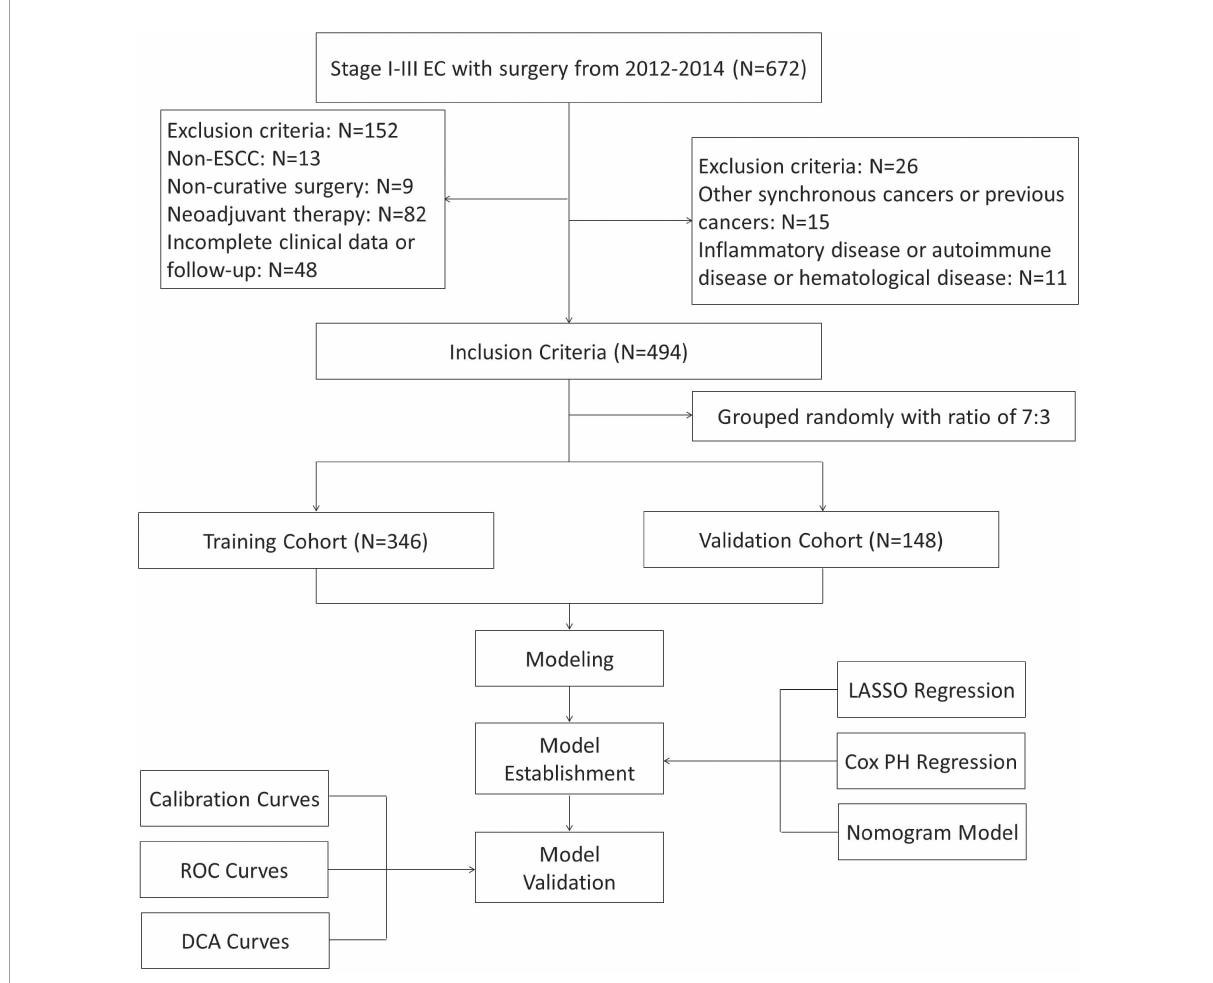
FIGURE1 The flow diagram of selection esophageal squamous cell carcinoma (ESCC) patients with radical resection. Based on the inclusion and exclusion criteria, a total of 494 patients were randomly